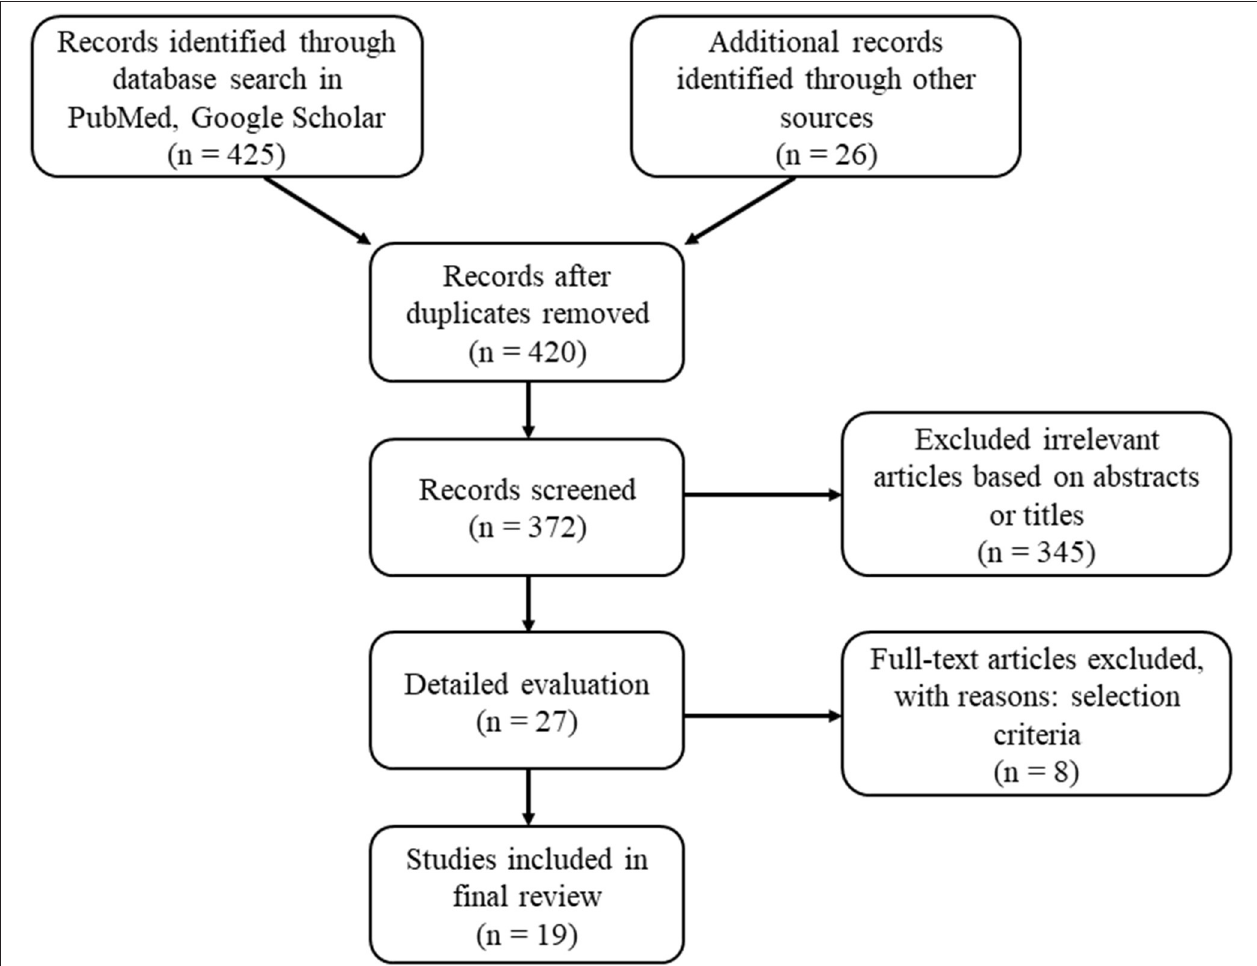
FIGURE 1 | Flow chart of the included studies regarding dietary intake among adult patients with